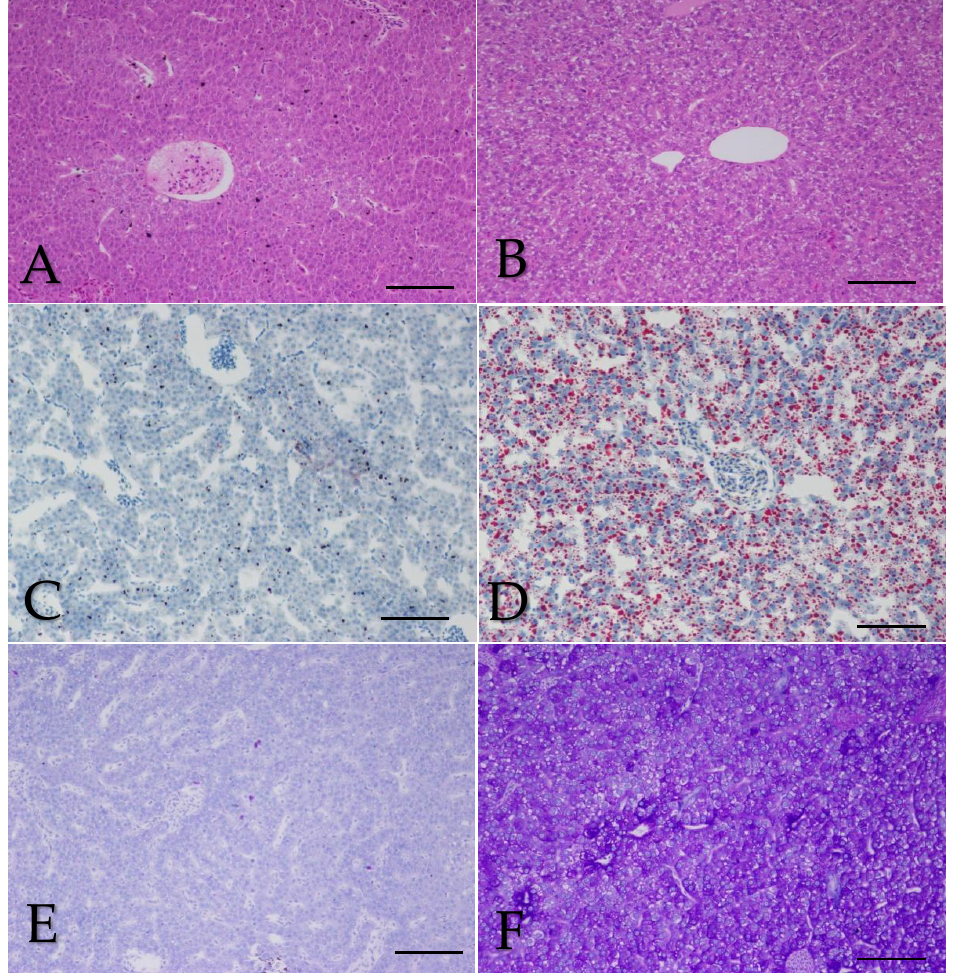
Figure 7. Liver morphology ( A , B ) (H.E., bar = 200 µ m), lipid ( C , D ) (O.R.O., bar = 200 µ m) and glycogen ( E , F ) (PAS, bar = 200 µ m) stained by H.E, Oil Red O and PAS between wild and cultured Hemibarbus maculatus . Rounded vacuole was observed in the cultured group (Figure 7B) but very